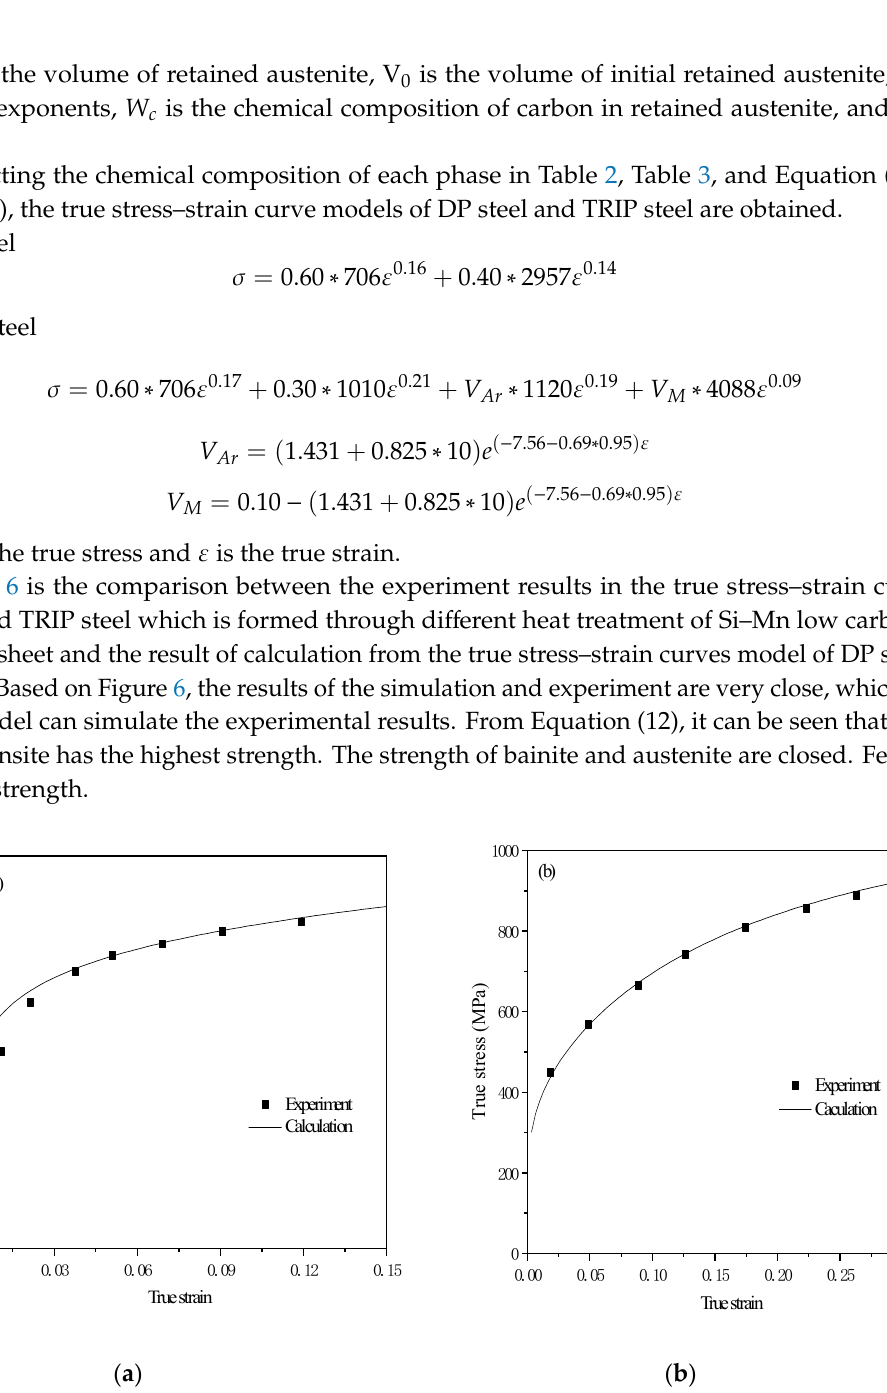
Figure 6. Calculation result and experiment result: ( a )Dual Process (DP) steel; ( b )Transformation Induced Plasticity (TRIP) steel.